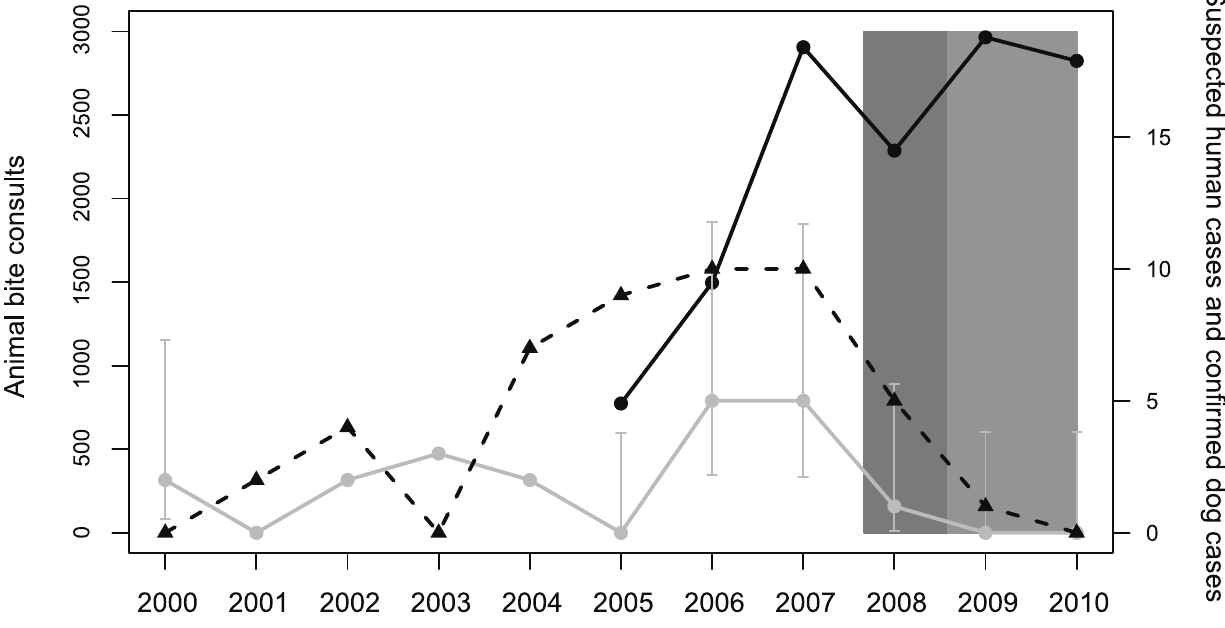
Figure 2. Number of suspected human cases (black triangles and black dashed line), reported animal bites (black dots and black solid line) and laboratory confirmed dog cases with 95% CI (gray dots and gray solid line), Bohol Province, 2000–2010. The shaded areas indicate the timing of round 1 (darker gray) and round 2 (lighter gray) mass dog vaccination.